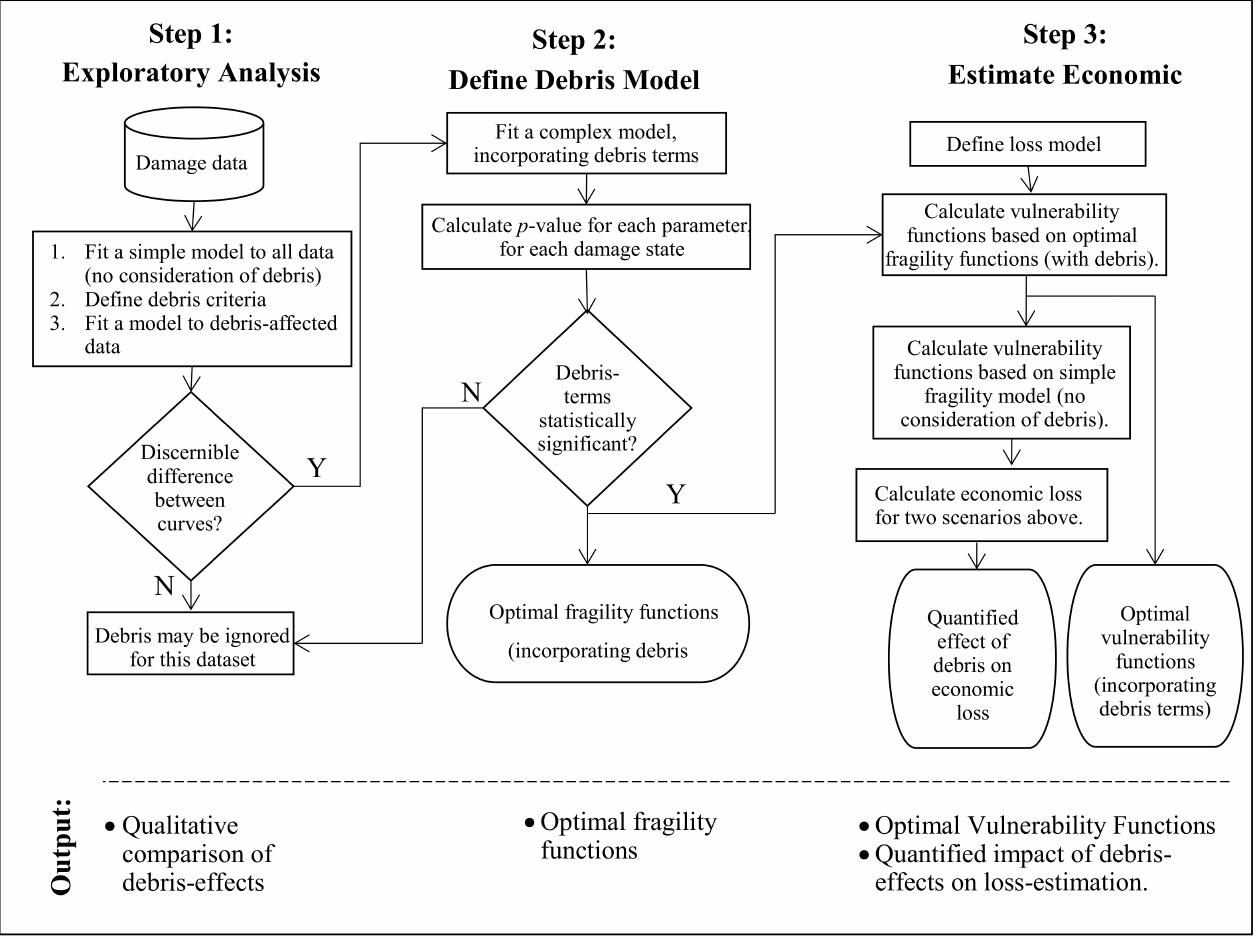
Figure 3. Flow chart showing the 3-step methodology presented in this paper, to quantify the effect that debris-induced damage has on fragility and vulnerability function derivation, and subsequent loss